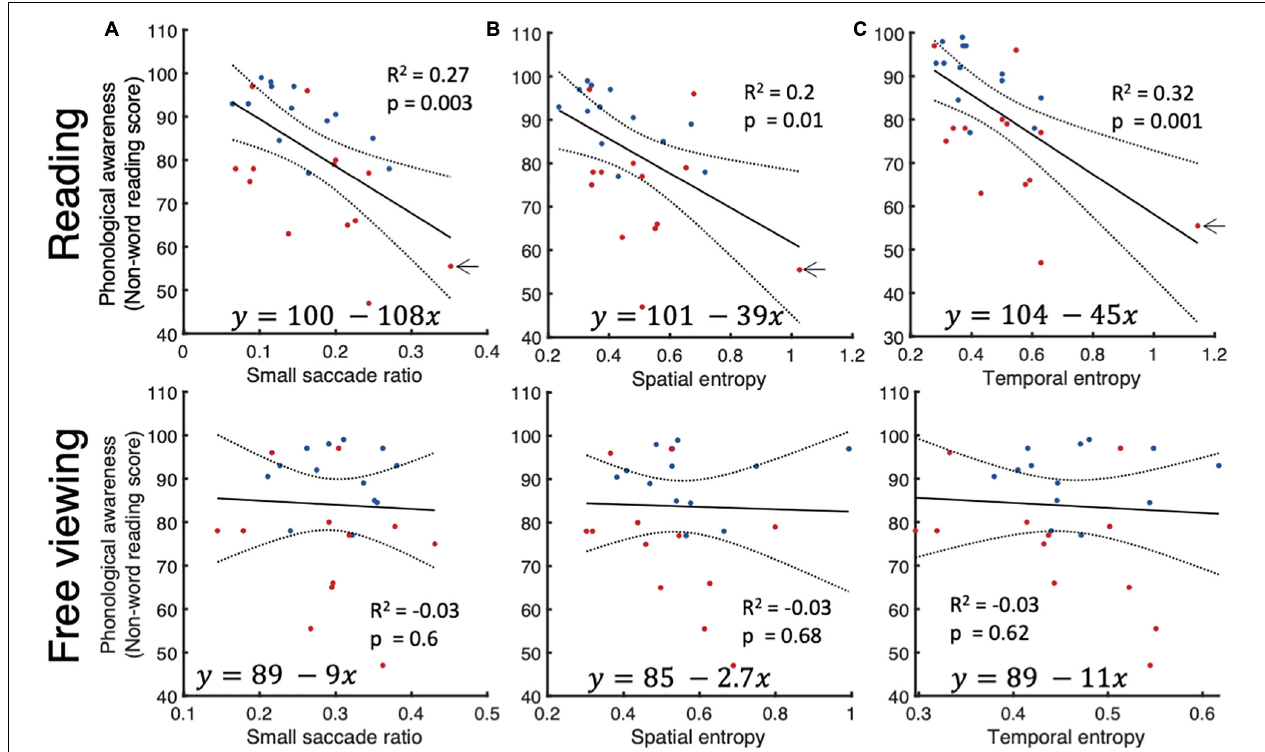
FIGURE 6 | Relationship between phonological awareness and small saccade parameters. Linear regression analysis between phonological awareness scores on one hand and small saccade ratios (A) , (B) spatial entropy, and (C) temporal entropy on the other for reading (top row) and free viewing (bottom